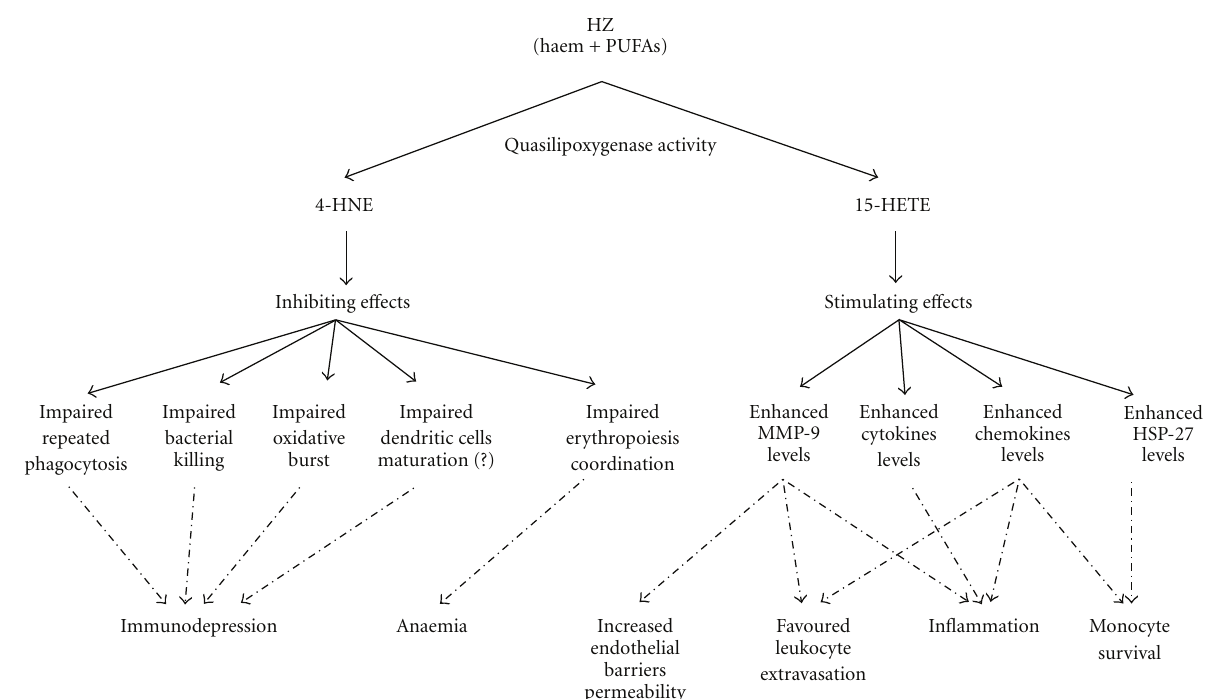
Figure 1: E ff ects of phagocytosis of HZ on human monocyte